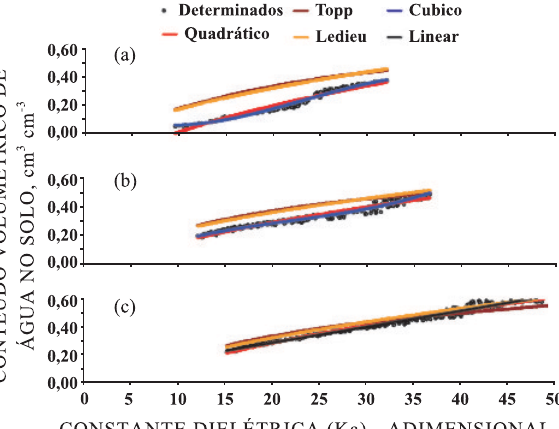
Figura 2. Estimativa do conteúdo volumétrico de água no solo por diferentes modelos em função da constante dielétrica, para Neossolo Quartzarênico (a), Cambissolo (b) e Latossolo Vermelho (c), comparados com os conteúdos de água determinados pelo método